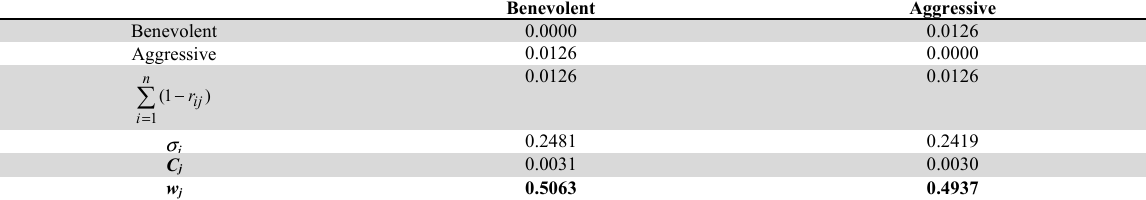
Criteria weights for fourteen international passenger airlines using the CRITIC method